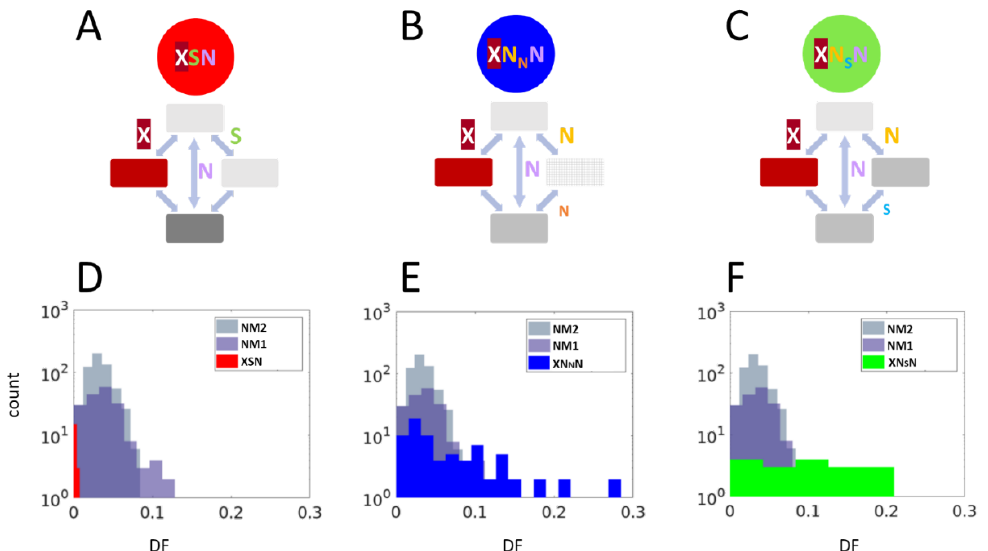
Figure 6. Types and distribution of double fraction (DF) relative to controls. ( A ) Double-substitutions XSN, in which a single substitution can be either synonymous or nonsense, while the double substitution is nonsynonymous, as compared to the ancestral state. ( B ) Double-substitution XN N N, in which a single substitution can be either nonsynonymous or nonsense, while the double substitution is nonsynonymous to the ancestral state, and the substitution between the intermediate nonsynonymous to the final nonsynonymous is nonsynonymous, as well. ( C ) Double-substitution XN S N, in which a single substitution can be either nonsynonymous or nonsense, while the double substitution is nonsynonymous to the ancestral state; however, the intermediate state is synonymous to the final state. ( D ) Distribution of DF values of XSN double substitution, compared to NM1 (syn_31) and NM2 (syn_33) control null models. ( E ) Distribution of DF values of XN N N double substitution, compared to NM1 and NM2 control null models. ( F ) Distribution of DF values of XN S N double substitution, compared to NM1 and NM2 control null models.